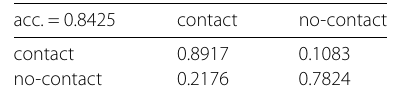
Table 5 Confusion matrix with accuracy of the HMM model with window size win = 6 acc. =